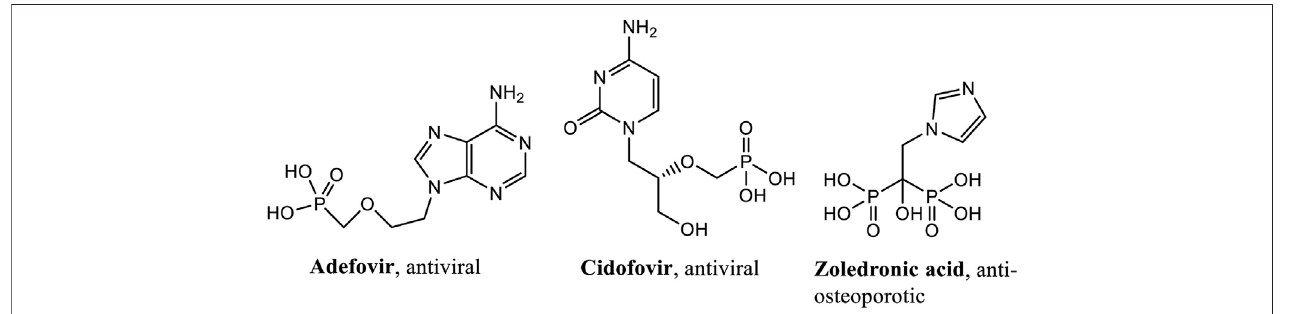
FIGURE 1 | Examples of phosphonate drugs of medicinal